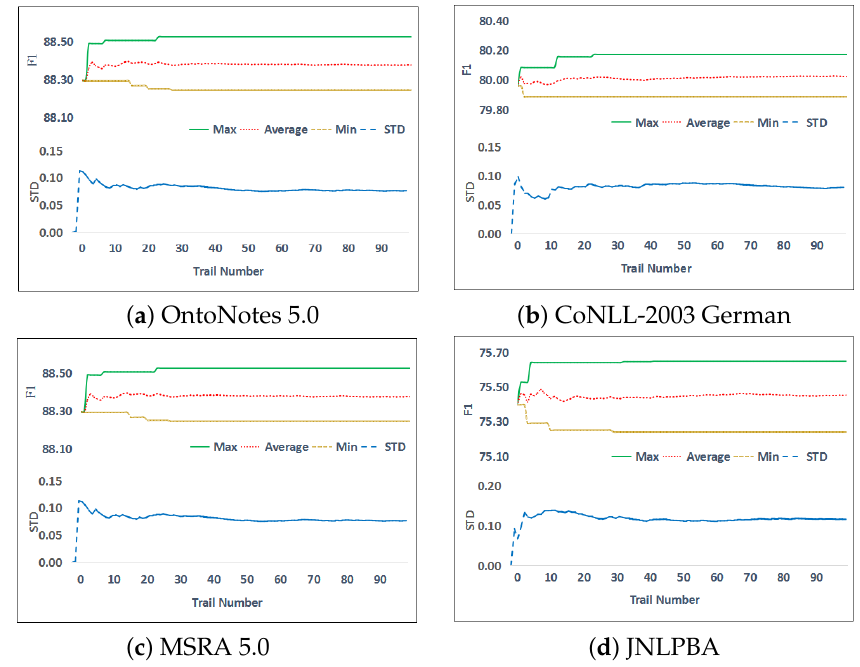
Figure 5. Max, average, min and standard deviation (STD) of the F 1 -scores of 100 random trails on the four datasets. X-axis denotes the trail time i ( i = 1,2,...,100). Y-axis denotes the corresponding values based on the experimental results of the first i trails.